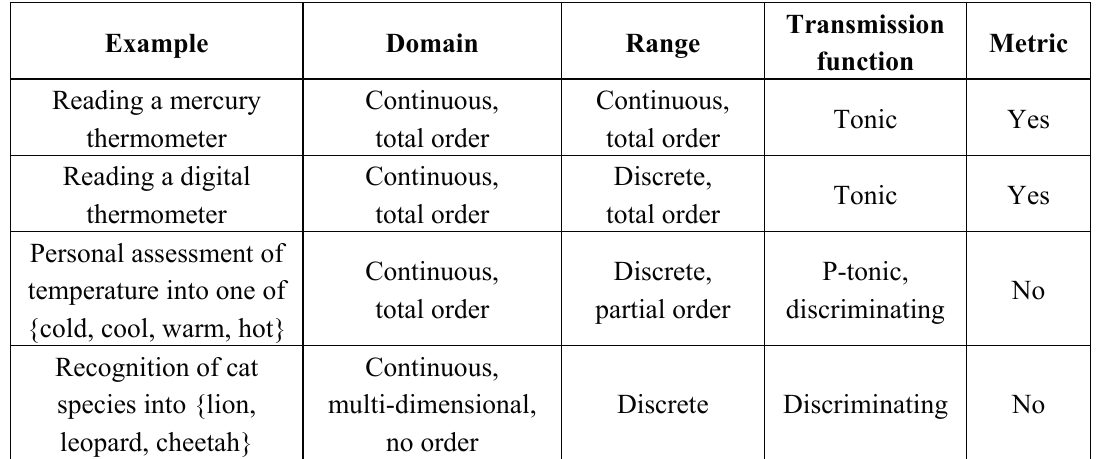
Table 4 . Properties of transmission functions for various